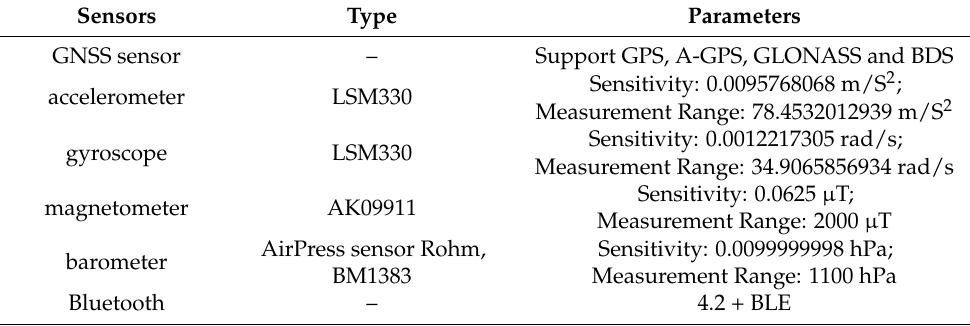
Table 7. Huawei mate 8 smartphone sensor and related parameters.